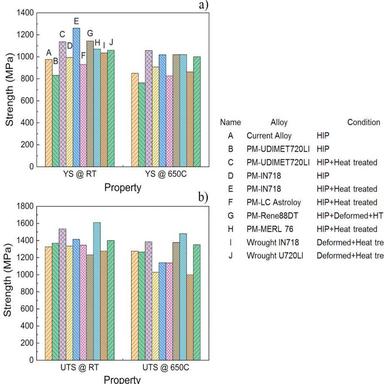
Comparative tensile behaviour of the studied HIPed superalloy with other P/M and wrought superalloys at room temperature and 650 ◦C.